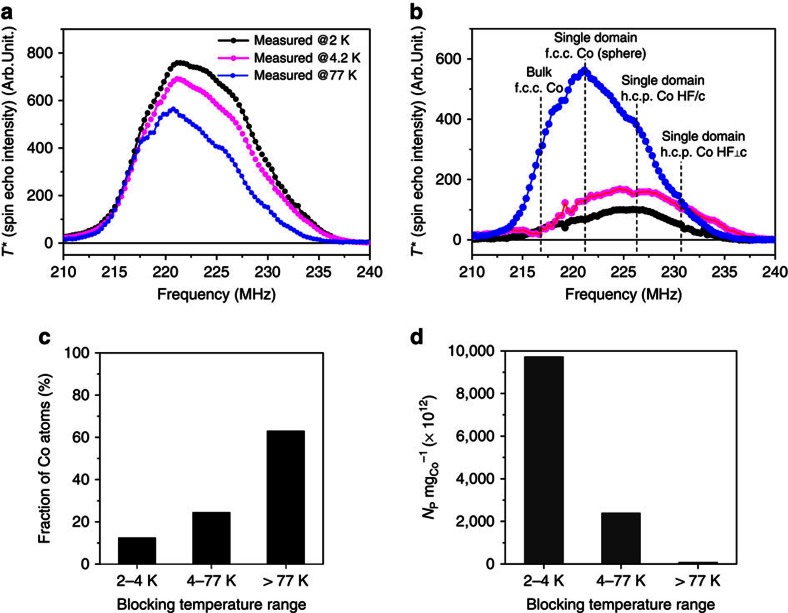
59Co FNR spectra of cobalt nanoparticles versus temperature.(a) The 59Co zero field FNR spectra recorded at 2 (black), 4.2 (magenta) and 77 K (blue). (b) TDFNR spectra: in black spectrum measured at 2 K minus spectrum measured at 4.2 K; in magenta spectrum at 4.2 K minus spectrum at 77 K; in blue spectrum at 77 K. Co can have an f.c.c. or an h.c.p. structure and be in two magnetic states: single domain or multi-domain. (c) The fractions of cobalt atoms engaged in the different blocking temperature ranges. (d) Numbers of Co particles per mg of cobalt (Np mgCo−1) in different blocking temperature ranges. 2–4.2 K range corresponds to 3–4 nm particles, 4.2–77 K range to 4–10 nm; >77 K corresponds to particles larger than 10 nm.